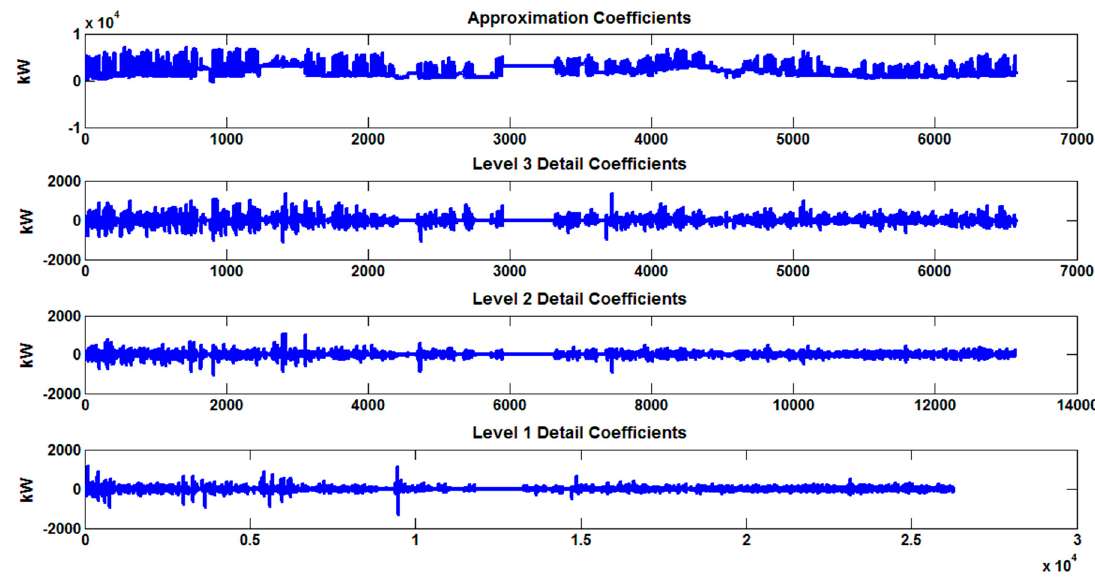
Figure 7. Original electricity demand data and its WT extracted features.